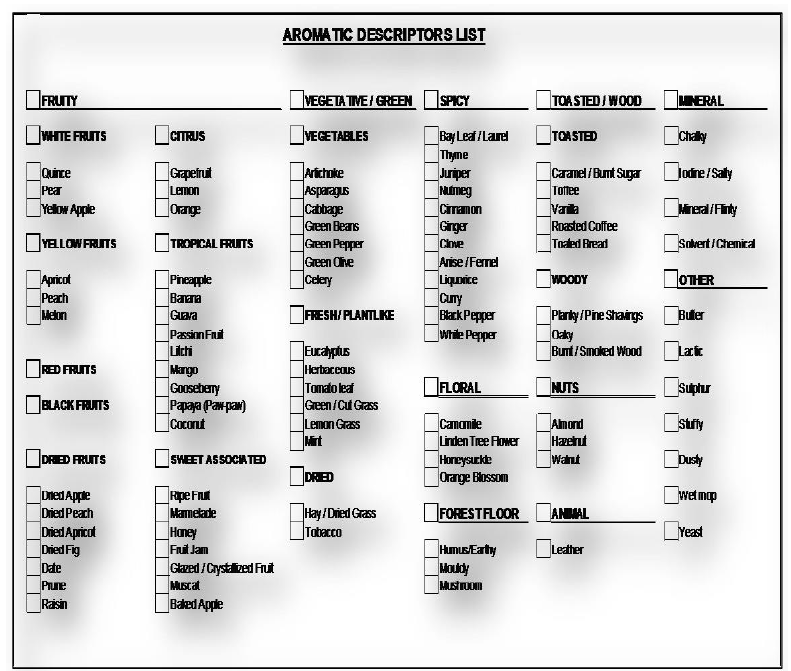
Figure A1. Tasting sheet used by the panel during the different stages investigated.